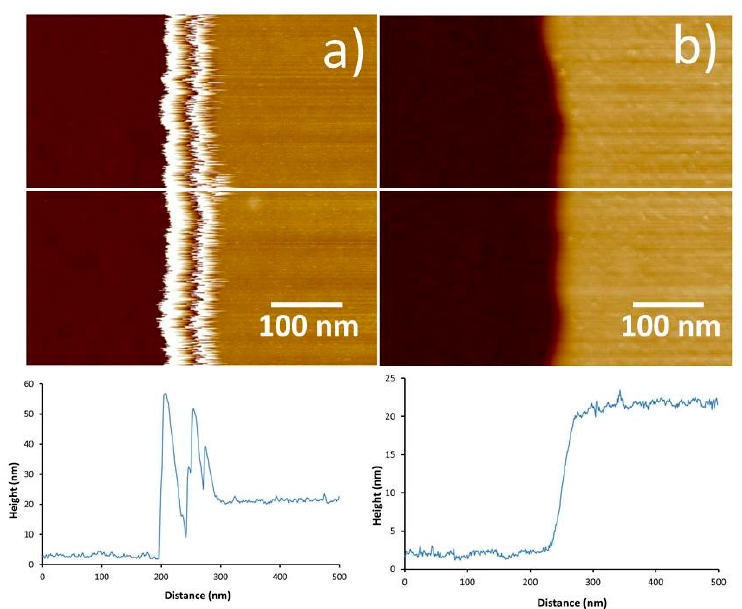
Figure 5. AFM images and corresponding cross sections of a Mikromasch TGZ01calibration grid with 20 nm deep parallel trenches using the CNT3 probe. ( a ) was acquired in tapping mode while ( b ) was acquired using PFT. The white lines represent the positions of the cross sections underneath each image. From the images and cross sections, it is obvious that the “ringing” artefact is eliminated when using CNT-AFM tips in PFT mode. The height or color scale for both images is 50 nm.